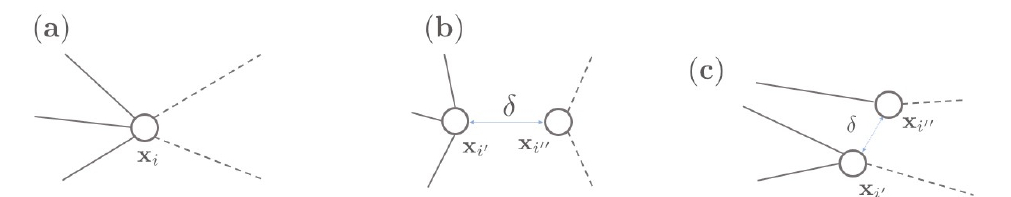
Figure 1. ( a ) A node that corresponds to two real-life entities that belongs to two communities. Links that connect the node with different communities are plotted in either full lines or dashed lines. ( b ) an ideal split that aligns well with the communities. ( c ) a less optimal split.